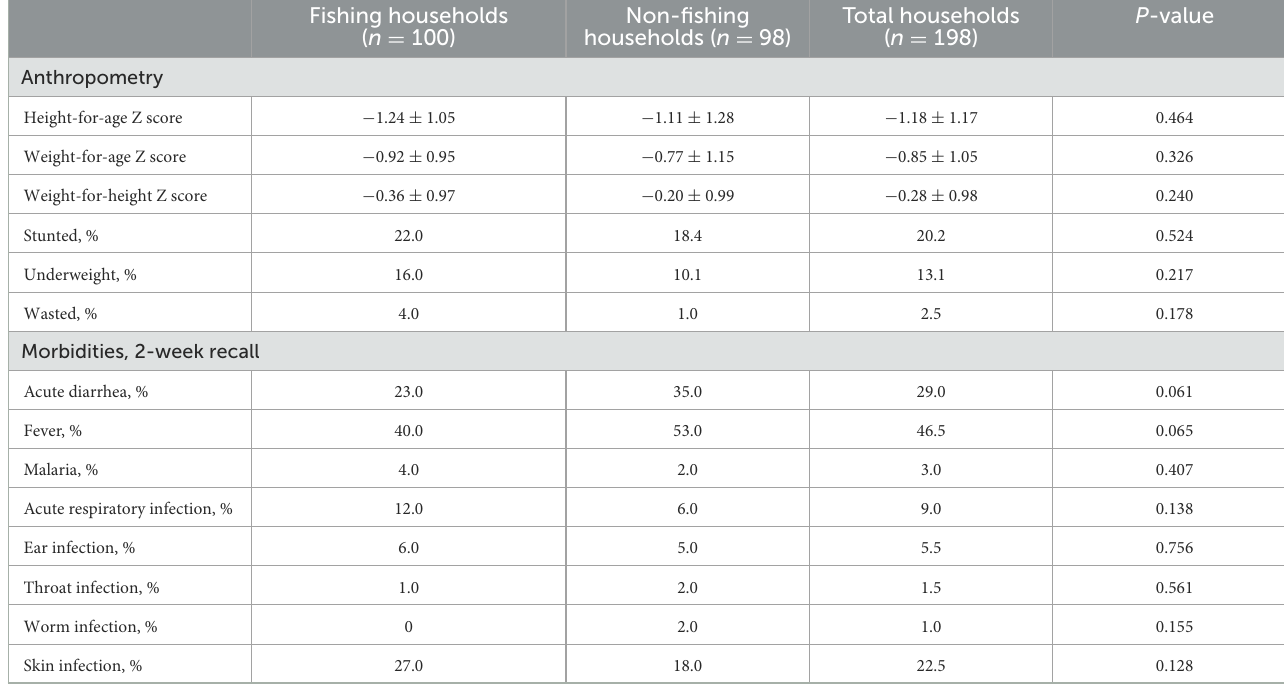
TABLE 2 Child health and nutrition status, by fishing and non-fishing